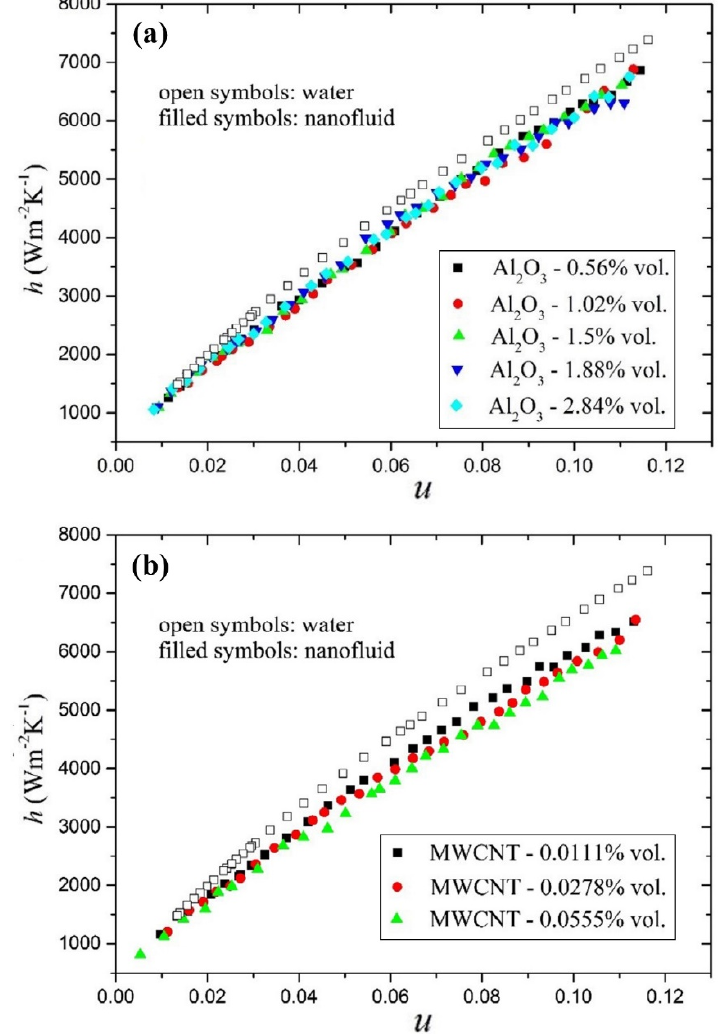
Figure 11. Variations of the convective heat transfer coefficient versus flow velocity ( u ) in different solid concentrations for: ( a ) Al 2 O 3 ‐ water nanofluid, and ( b ) MWCNT ‐ water nanofluid. Reproduced with permission from [88]. Elsevier, 2015.